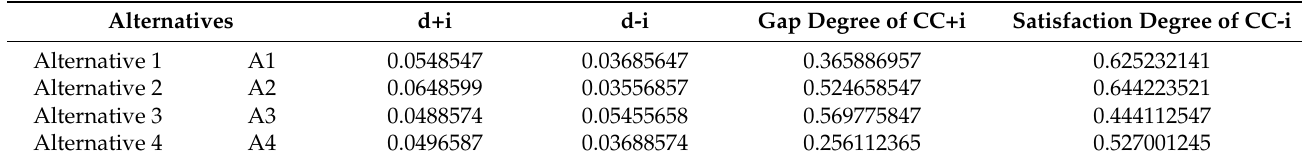
Table 6. Closeness coefficient of the detachments level among alternatives.